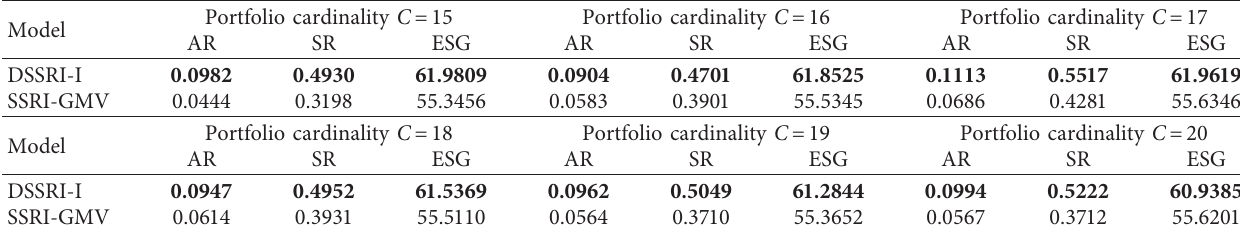
Table 4: Comparison of the DSSRI-I and the SSRI-GMV.